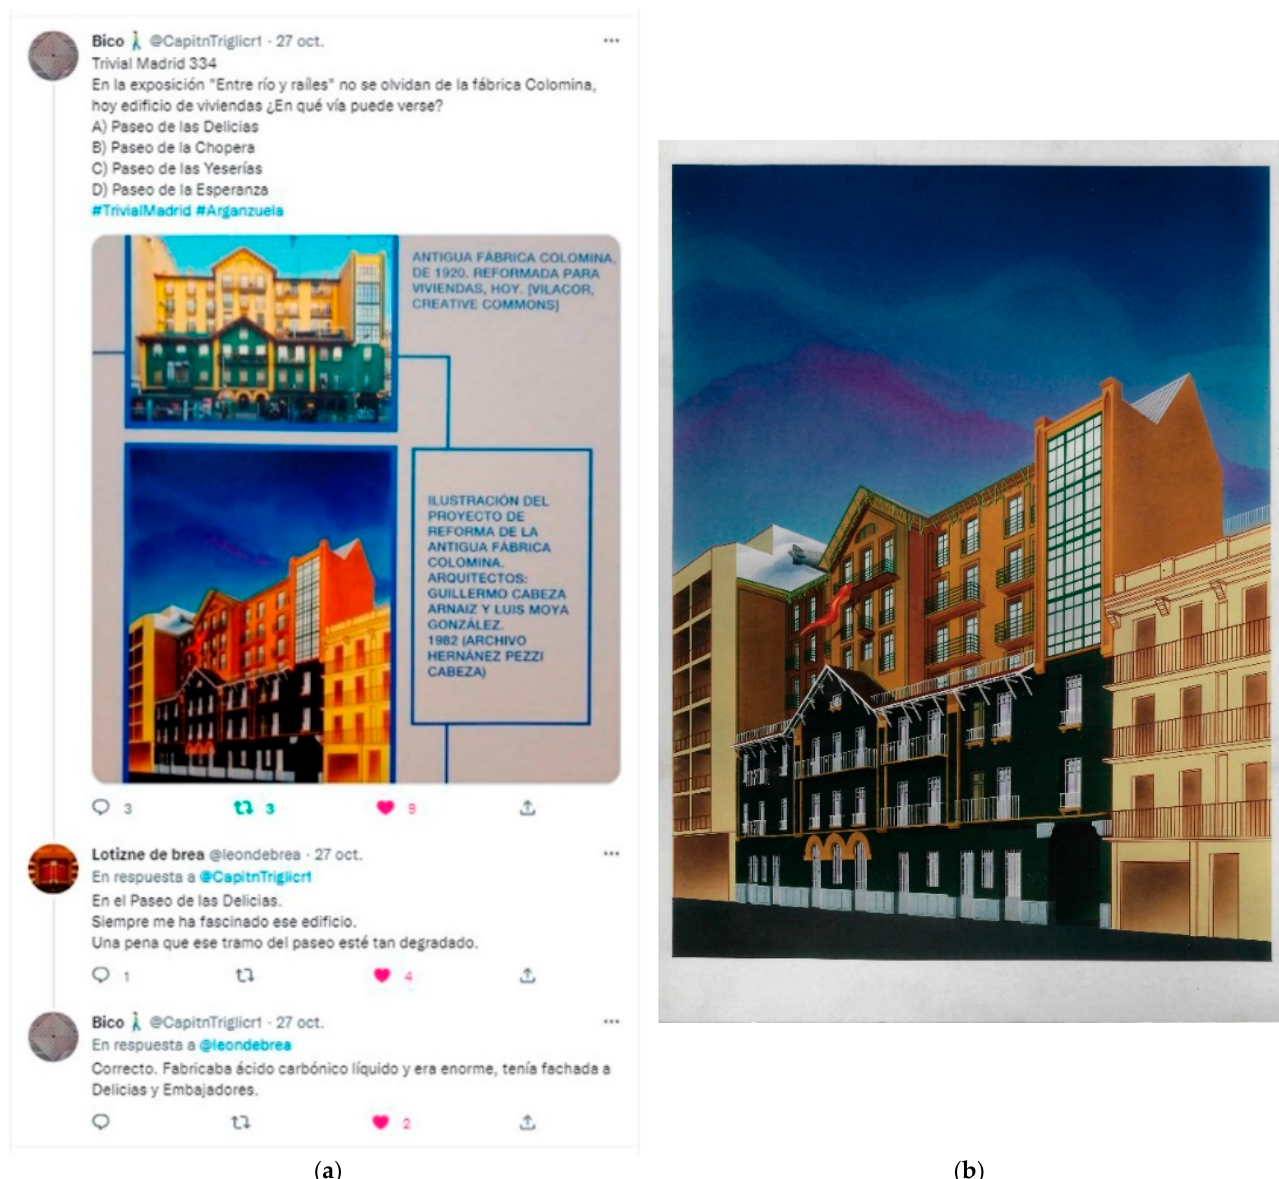
Figure 13. Twitter thread with a photo of a panel from the “Between river and rails” exhibition with a riddle about the Colomina factory. Here, Bico shares his memories and presents new information about the building before the remodeling. ( a ) Twitter thread; ( b ) project of Moya and Cabeza from 1982. For others, it is an occasion for critical debate as one of the topics on how the models for financing and management of public space can influence its conservation or abandonment (Figure 14).